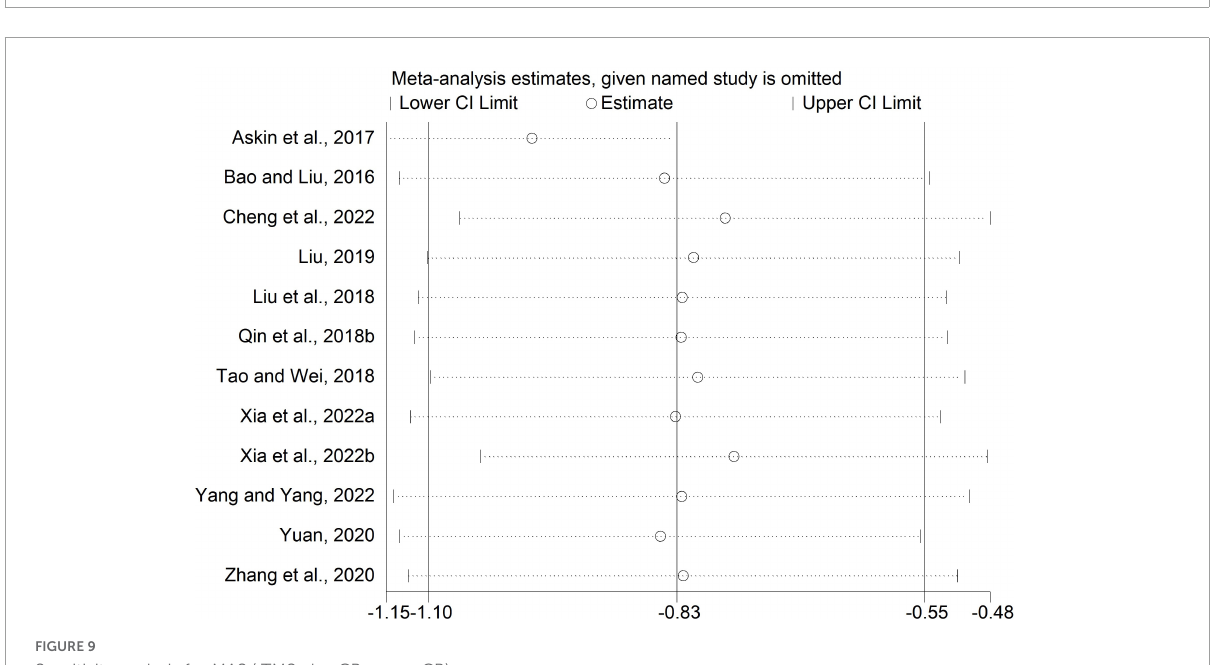
FIGURE8 Sensitivity analysis for MAS (rTMS plus CR versus sham rTMS plus CR).